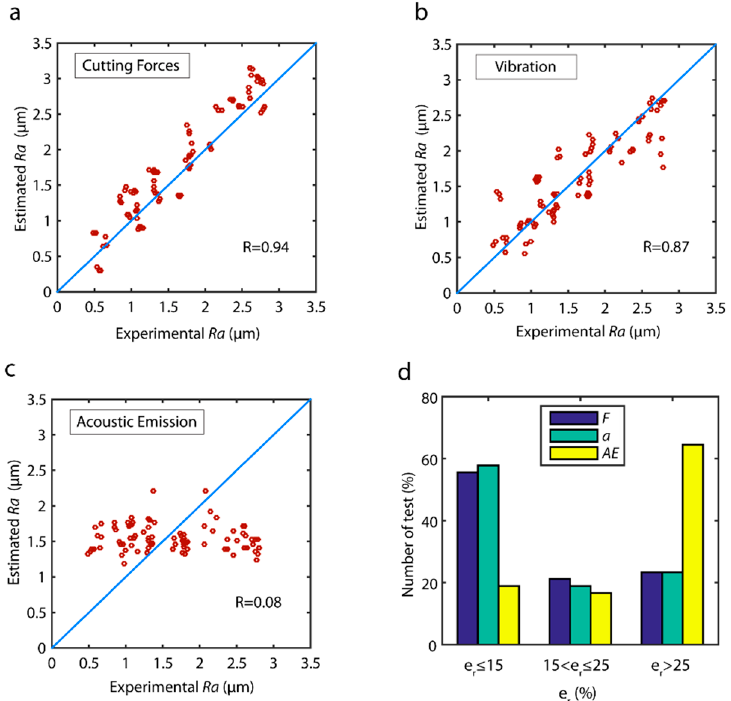
Figure 5. Estimated values versus experimental validation values for the parameter Ra with the TDA method: ( a ) cutting forces, ( b ) vibration, and ( c ) acoustic emission. ( d ) Prediction reliability with the TDA method.